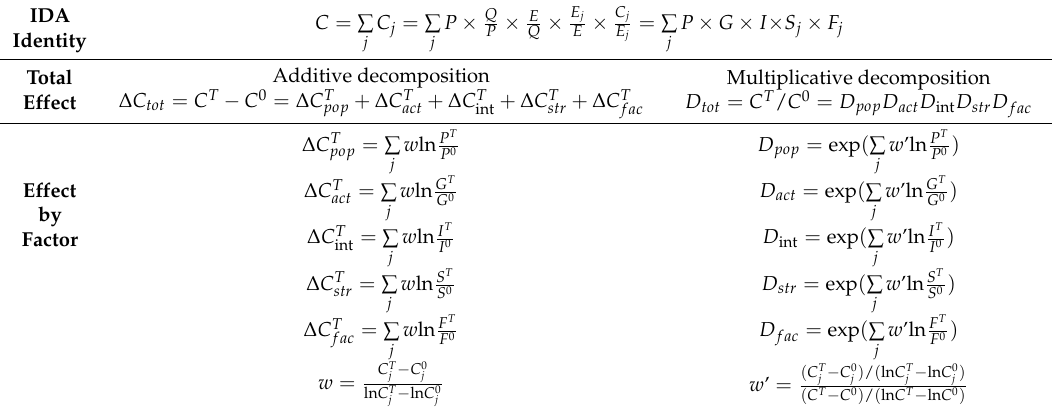
Table 2. LMDI formulas for decomposition changes in energy-related CO 2